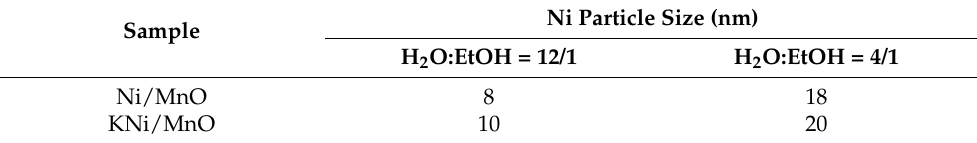
Figure 10. Microscopic analysis of the KNi/MnO x catalyst after 18 h of SRE reaction at 420 ◦ C (H 2 O/EtOH molar ratio = 12/1). HRTEM images ( a 1 , a 2 , a 3 , a 4 ) and STEM-EDS analysis ( a 5 ). Table 3. Ni particle size of the Ni/MnO x and KNi/MnO x catalysts after SRE reaction.